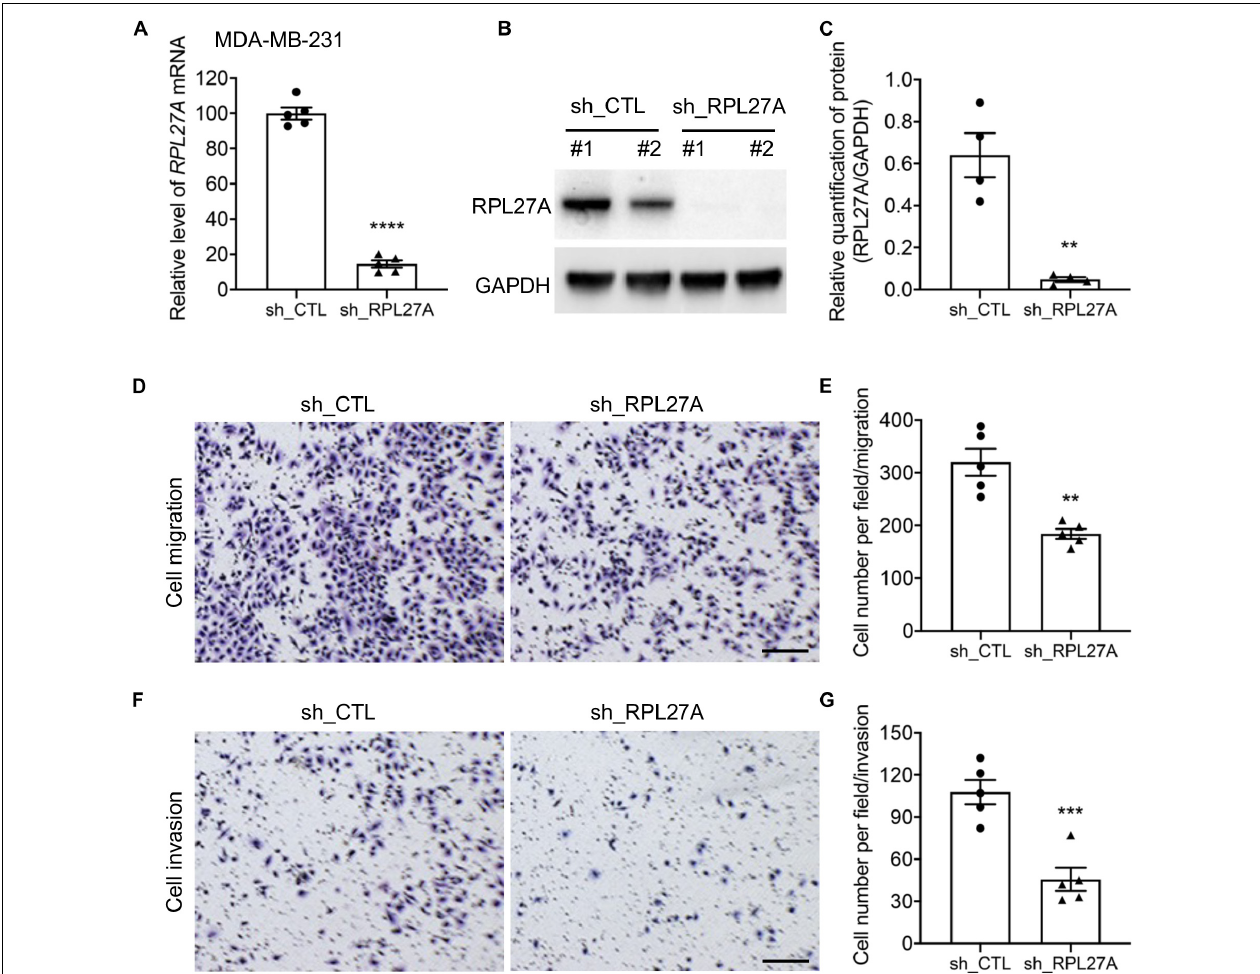
FIGURE 5 | RPL27A knockdown decreased cell migration and invasion in the TNBC cell line. (A–C) Knockdown efficiency of RPL27A in MDA-MB-231 cells was confirmed by qRT-PCR (A) and western blot (B,C) . (D,F) Representative images of migration (D) and invasion (F) assays on RPL27A-knockdown and controls cells. (E,G) Quantification of cell numbers in each image of migration (E) and invasion (G) assays. Scale bar, 50 µ m. ** p < 0.01; *** p < 0.001.